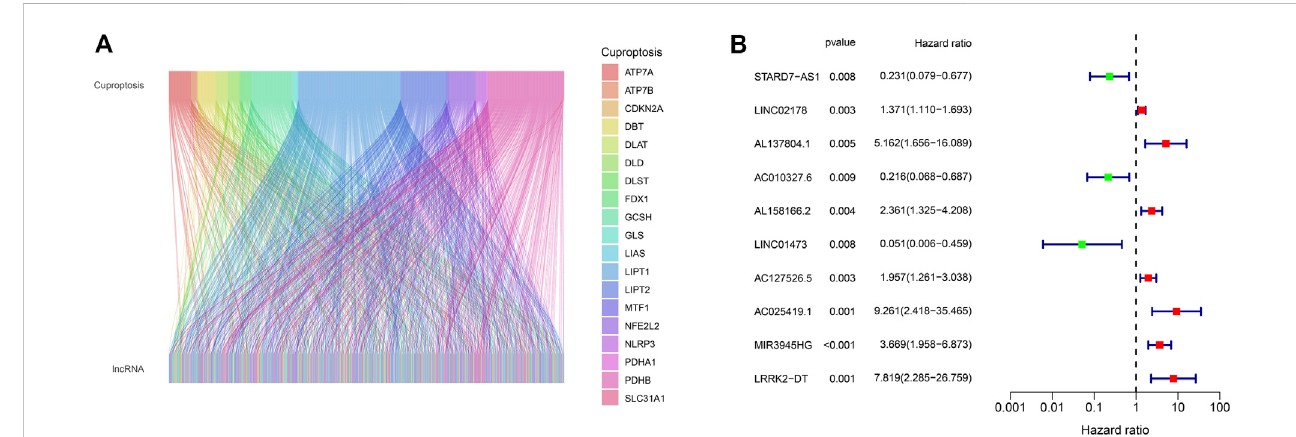
FIGURE 2 (A) Alluvial plot of pearson correlation analysis between 990 CRLs and 19 cuproptosis regulators. (B) The hazard ratio and expression of 10 prognostic CRLs.